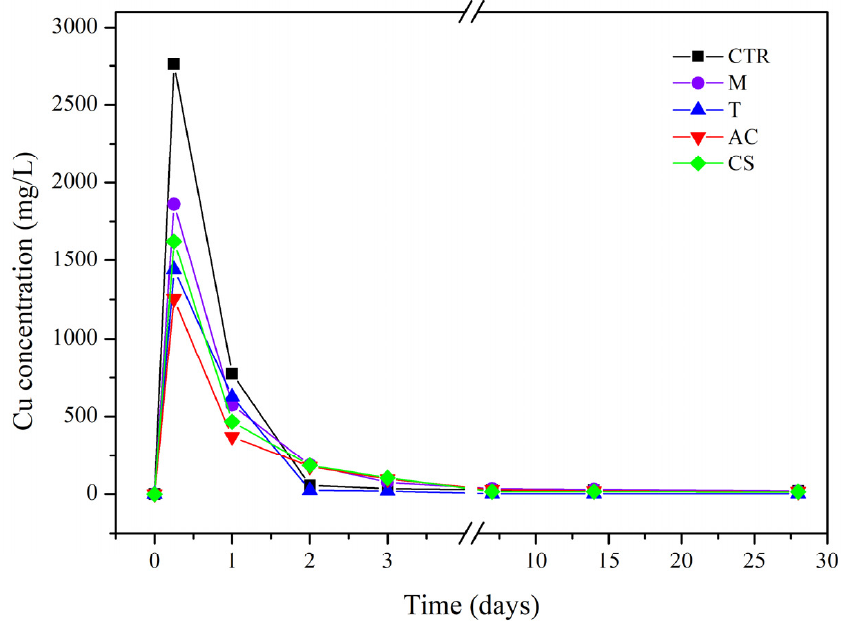
Figure 3. Cu breakthrough curves in column leaching test with and without amendments at a flow rate of 1 mL/min condition (CTR: control; M: magnetite; T: talc; AC: activated carbon; CS: cornstarch).